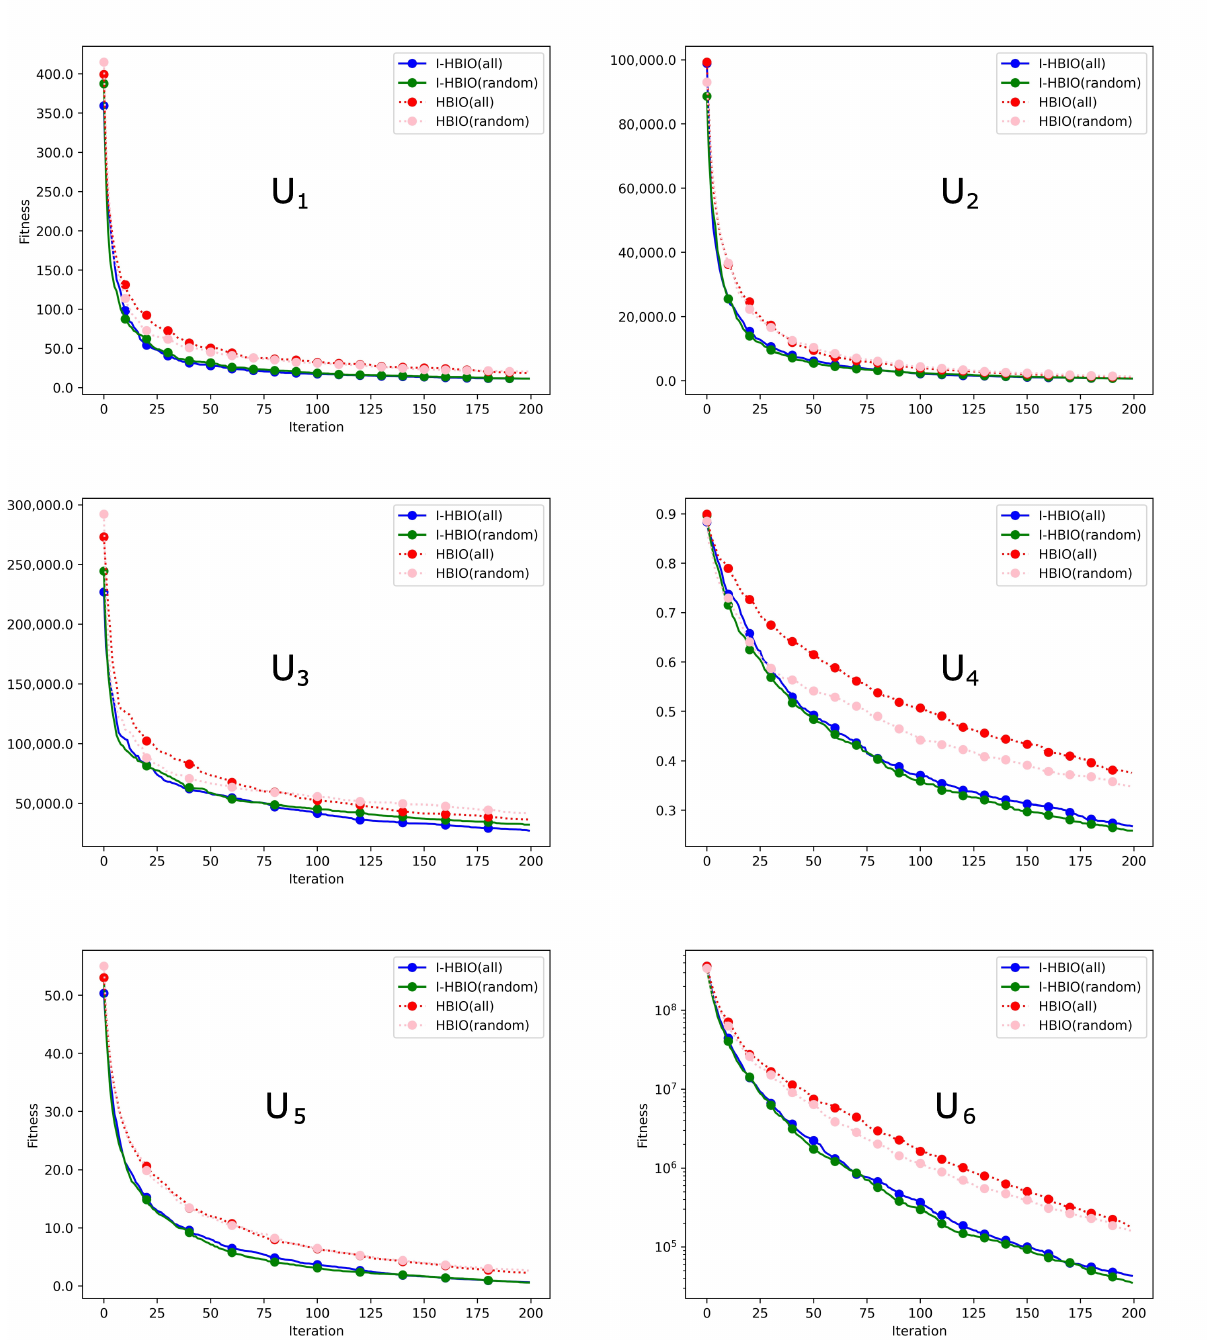
Figure 14. Optimization results on unimodal benchmark